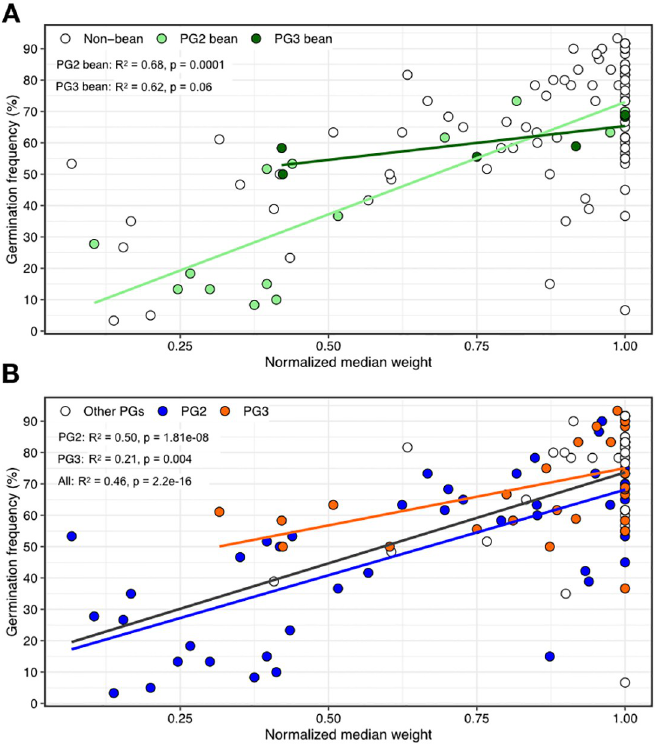
Fig 6. Correlation between germination frequency and virulence of seed infected bean plants. (A) Germination frequency vs virulence (i.e., normalized fresh weight) stratified by PG2 and PG3 bean isolates. A strong correlation is found between germination frequency and virulence of bean strains from PG2 (linear regression; F = 28.91, df = 13, p = 0.00012, r 2 = 0.66). (B) Germination frequency vs. virulence stratified by PG irrespective of host.